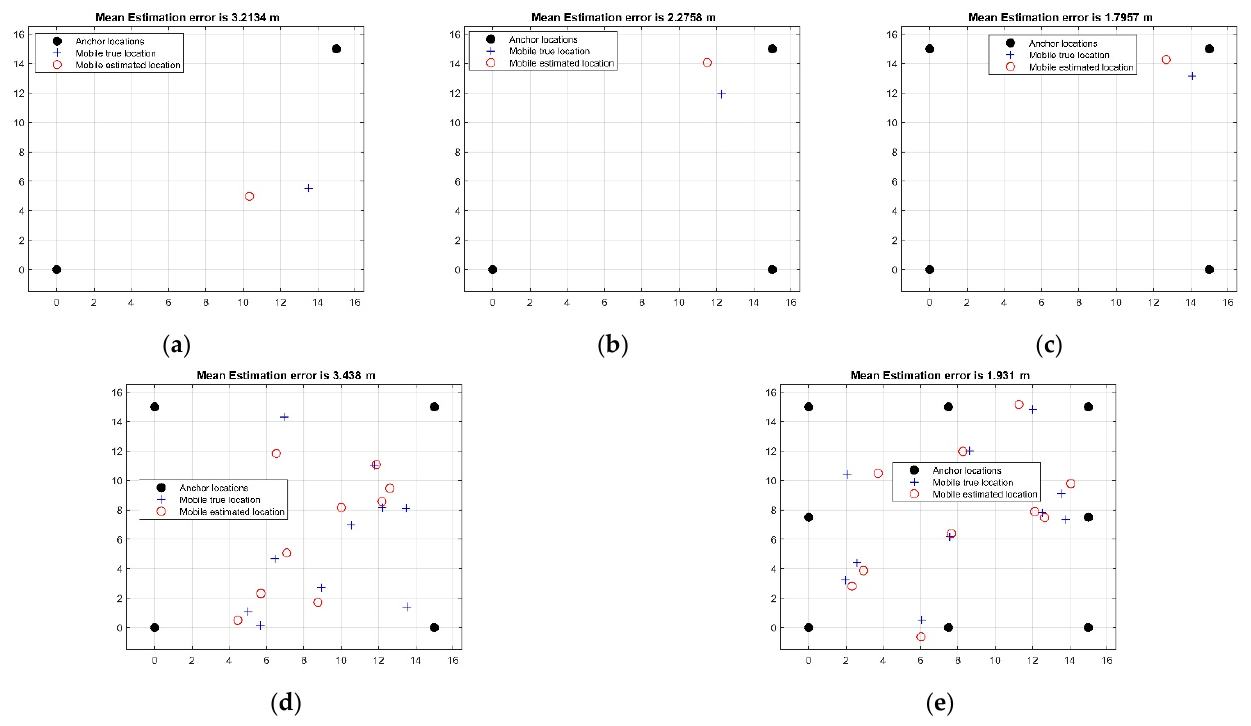
Figure 10. Localization results for C 2 C 2 . ( a ) Localization estimation of one sensor node with two anchor nodes. ( b ) Localization estimation of one sensor node through trilateration. ( c ) Localization estimation of one sensor node through four anchor nodes (Multilateration). ( d ) Localization estima- tion of ten sensor nodes through four anchor nodes (Multilateration). ( e ) Localization estimation of ten sensor nodes through eight anchor nodes